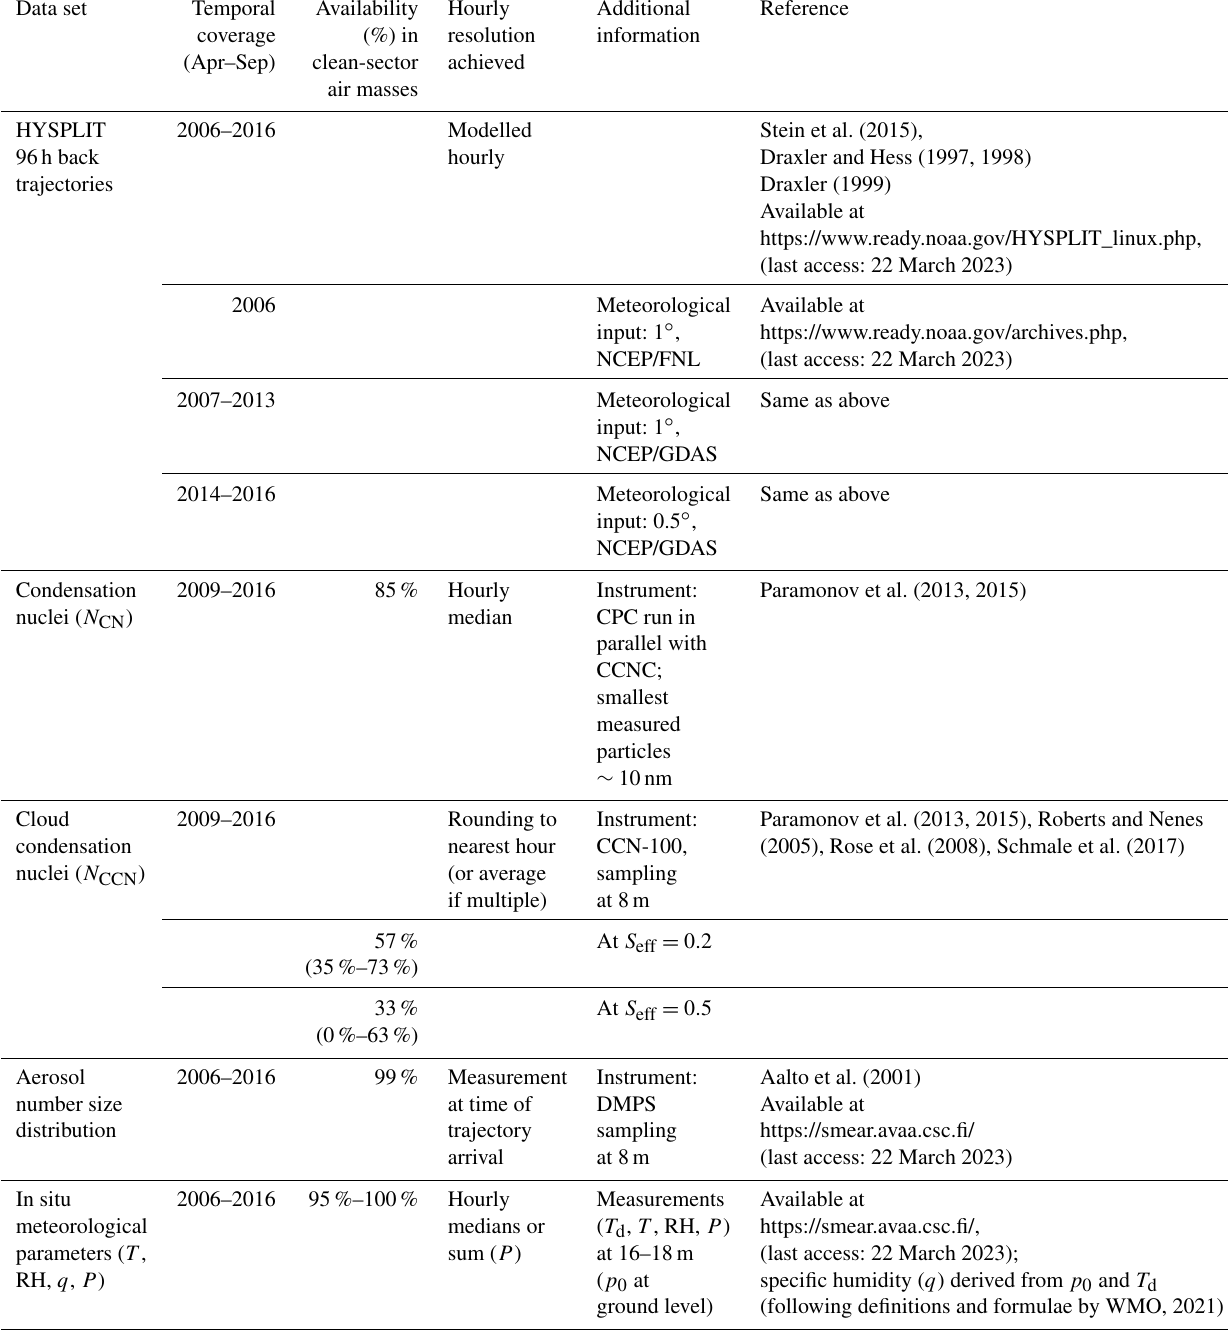
Table 1. A summary of the data sets used in this study. The meteorological inputs for the HYSPLIT simulations were from the US National Oceanic and Atmospheric Administration’s (NOAA) Air Resources Laboratory’s (ARL) archives of the National Centers for Environmental Prediction (NCEP) meteorological model data. This included data from the FNL archive and two Global Data Assimilation System (GDAS) archives (freely available on their website). Satellite observations were averaged over a 1 ◦ × 0 . 5 ◦ geographical grid, which at this location corresponds to approximately 53km × 56km. The numbers in brackets in the availability column indicate variation between